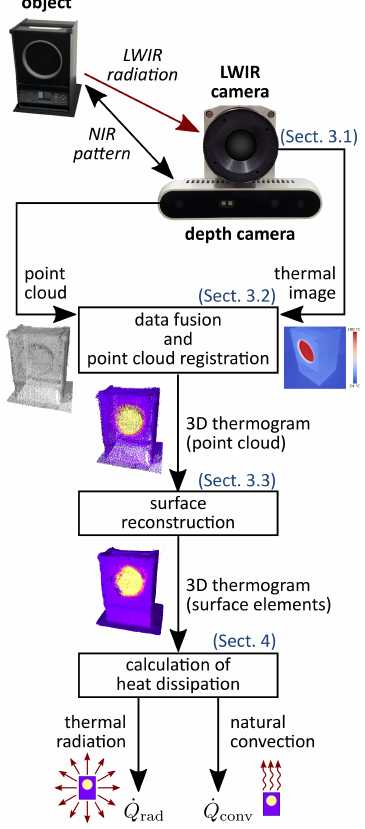
Figure 1. Workflow of surface heat dissipation measurement using 3D